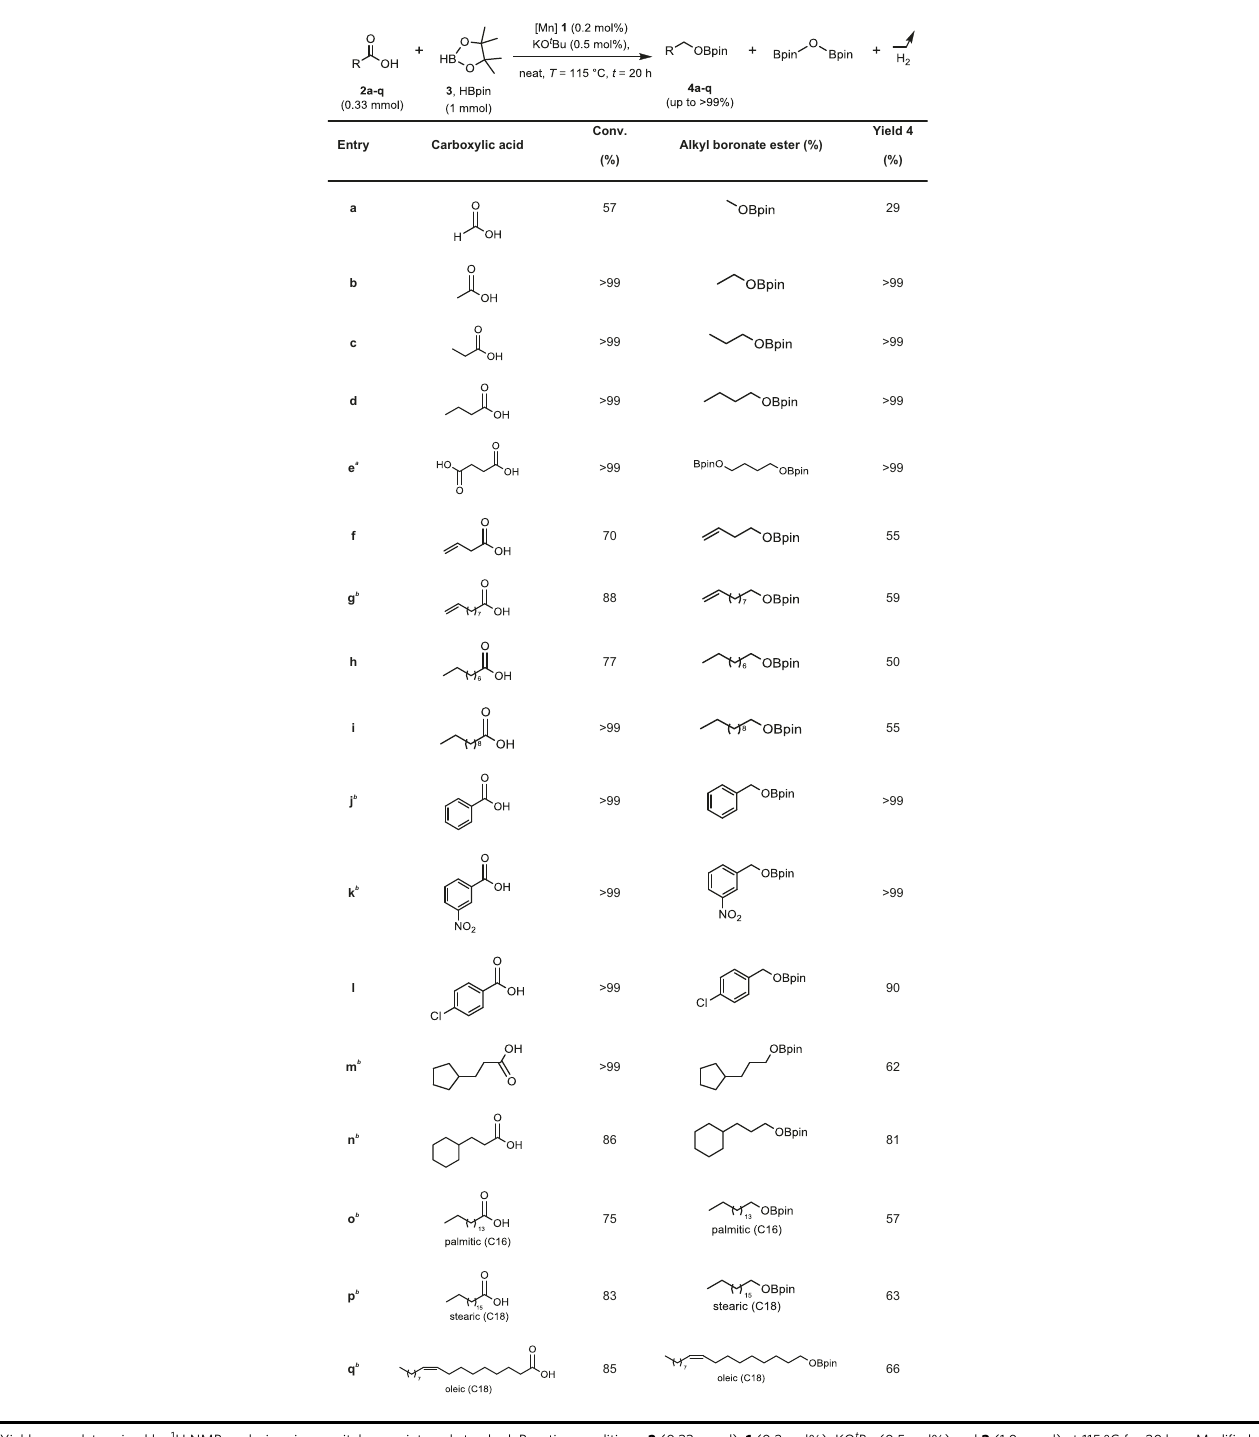
Entry Carboxylic